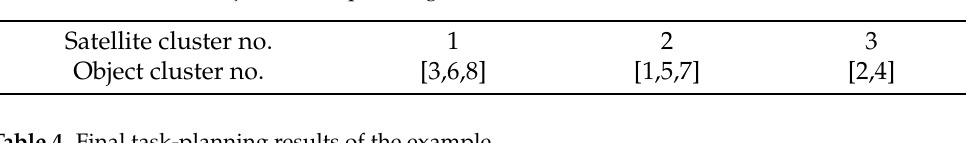
Table 3. Satellite- and object-cluster planning results.